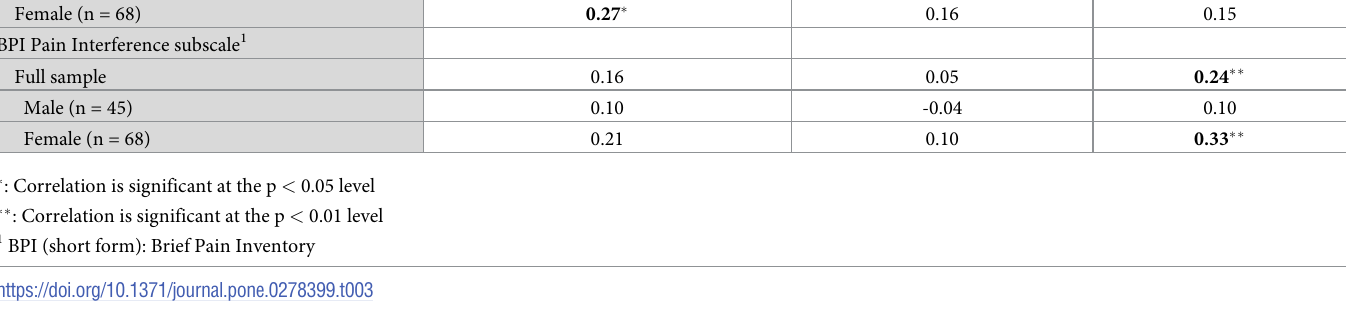
Table 3 contains correlations between GPES subscales and the BPI subscales, both as an over- all sample and when stratified by sex. Significant associations were found between the GPES subscale ‘Relationship-oriented’ and BPI Pain Severity (r = 0.20, p < 0.05), and between GPES ‘Emotive’ subscale and BPI Pain Interference (r = 0.24, p < 0.01). In the sex-disaggregated analysis, both the GPES Relationship-oriented and GPES Emotive subscales showed a signifi- cant association, respectively, with BPI Pain Severity (r = 0.27, p < 0.05) and BPI Pain Interfer- ence (r = 0.33, p < 0.01) scores only in female participants. The GPES Goal-oriented subscale was not associated with either BPI subscales, either as an aggregate sample or when disaggre- gated by sex. Figs 1 and 2 provides a graphical representation of the associations between each of BPI Pain Severity and BPI Pain Interference with the independent variables for both males and females, respectively.